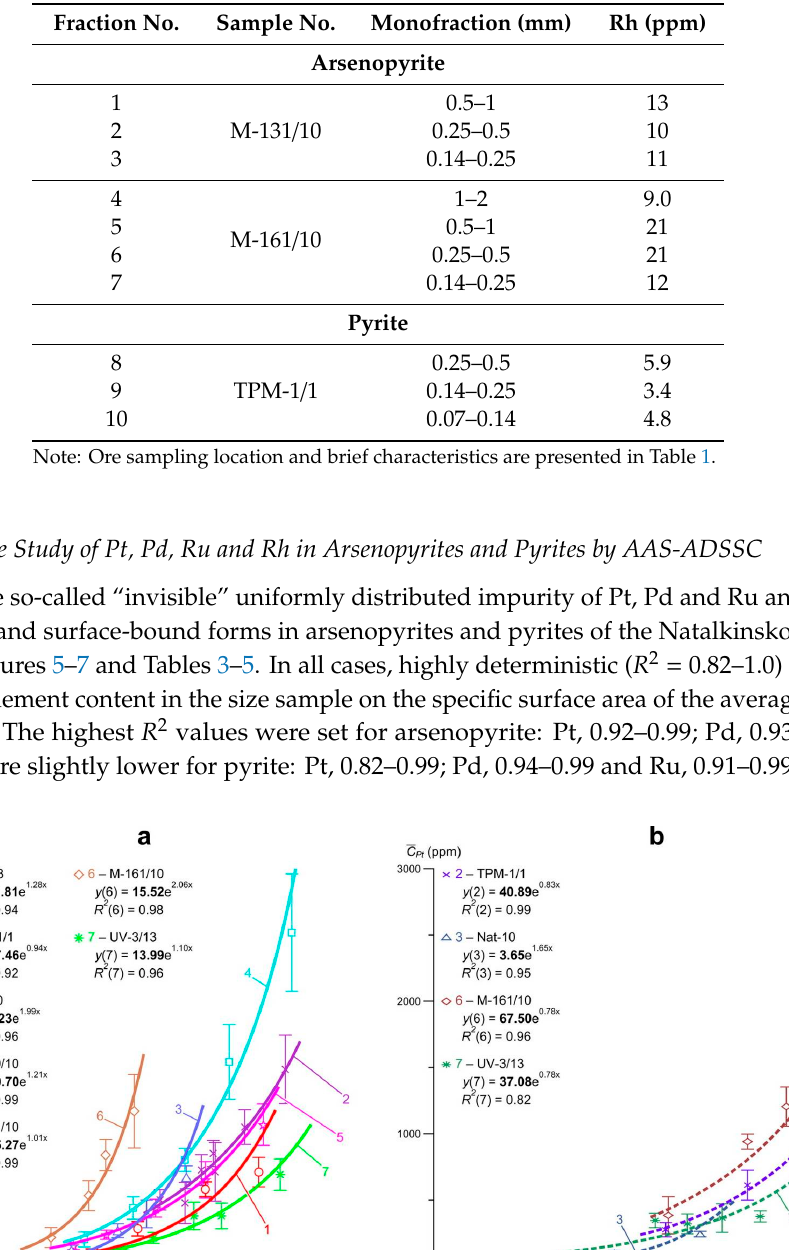
Table 2. The content of rhodium in the di ff erently sized monofractions of arsenopyrite and pyrite selected from vein and streaky-vein ores of the Natalkinskoe deposit.